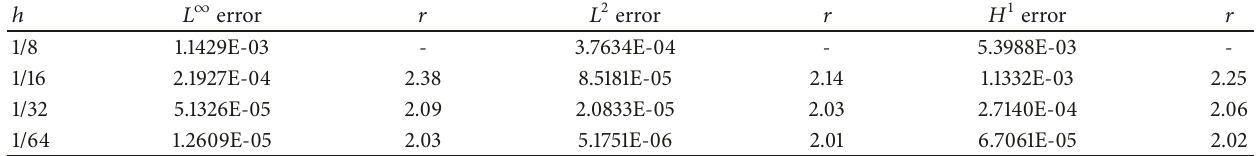
Table 2: Errors of the state for different error